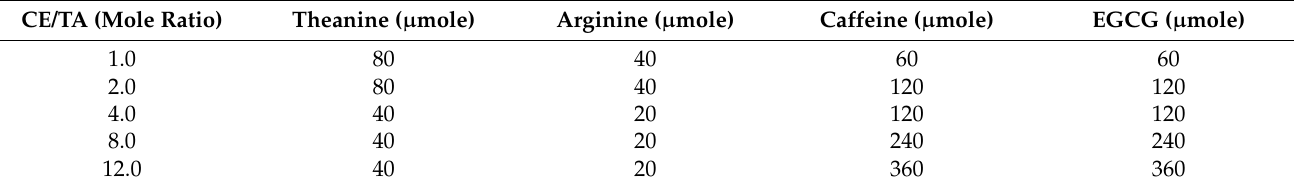
Table 3. Mole ratios of theanine, arginine, caffeine, and EGCG. CE/TA (Mole Ratio) Theanine ( µ